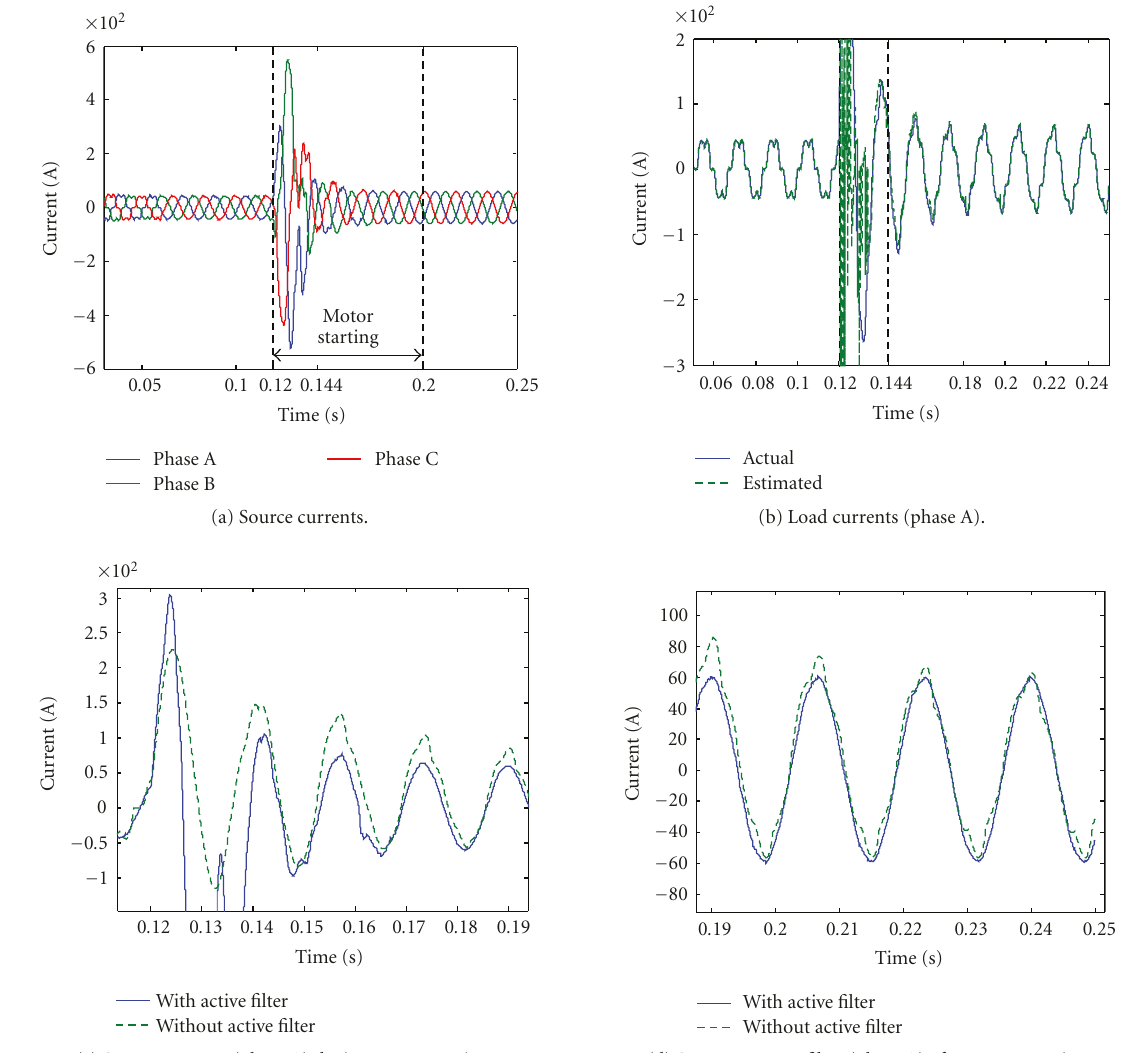
Figure 5: Simulation results of case 2 (Prony).